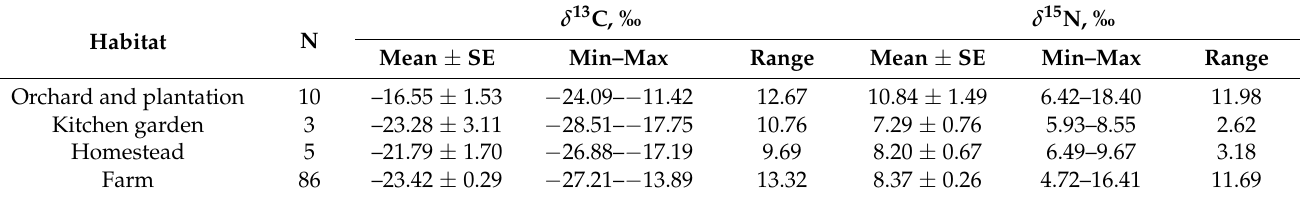
Table 3. Central position (mean ± SE) and ranges of hair stable isotope ratios of M. musculus